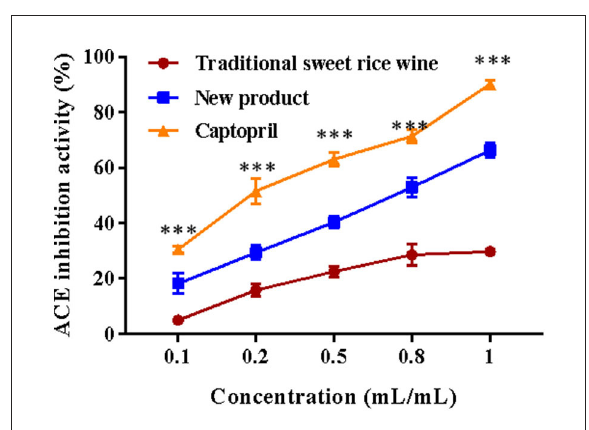
FIGURE9 Angiotensin-converting enzyme (ACE) inhibitory activity